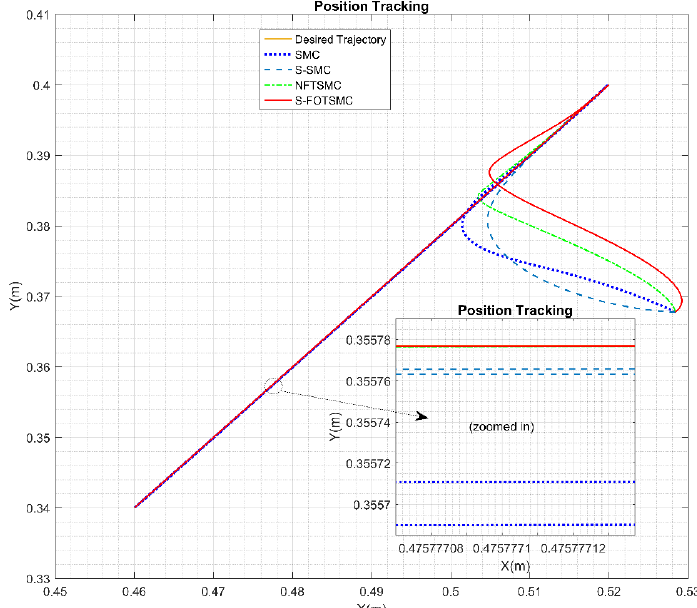
Figure 9. The desired trajectory and real trajectory of the end-effector when the parallel manipulator tracks a linear trajectory.